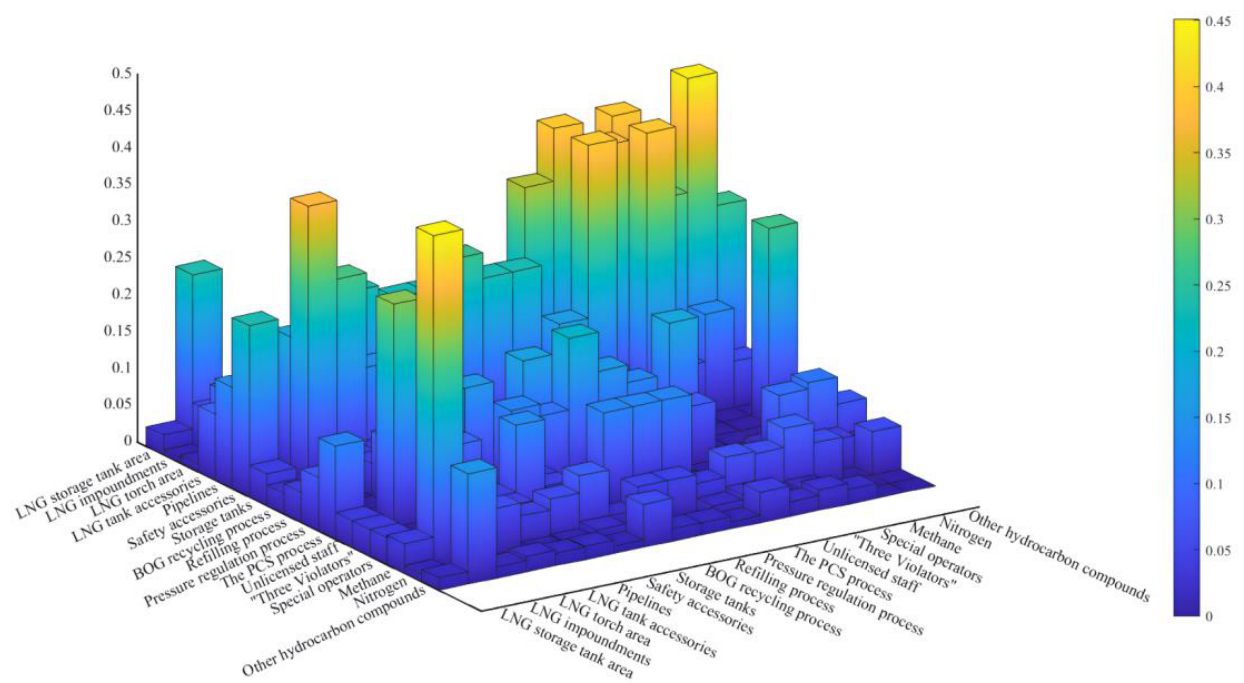
Figure 5. Three-dimensional correlation heat map of secondary indicators.